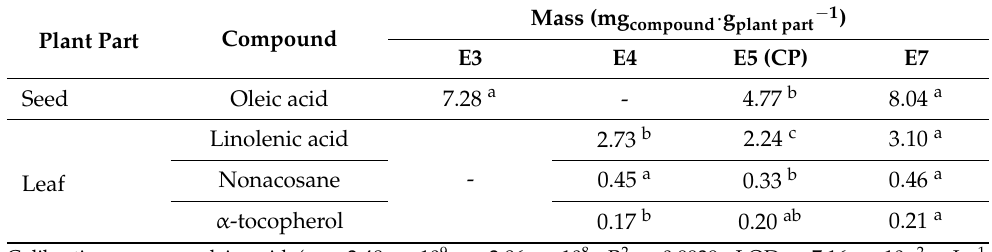
Table 6. Mass composition of target compounds obtained by SFE-CO 2 from Mo seed and